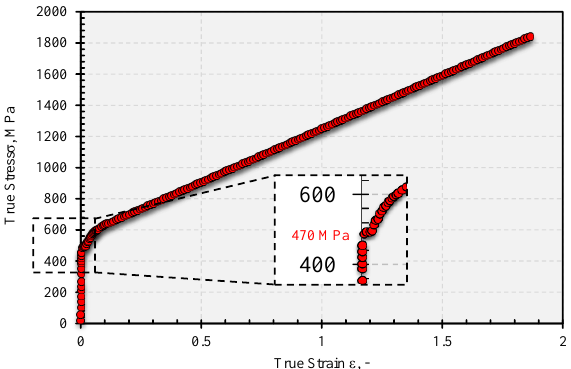
Metals 2020 , 10 , x FOR PEER REVIEW Figure 4. True stress-strain curve as the material input properties for determine the numerical analysis.